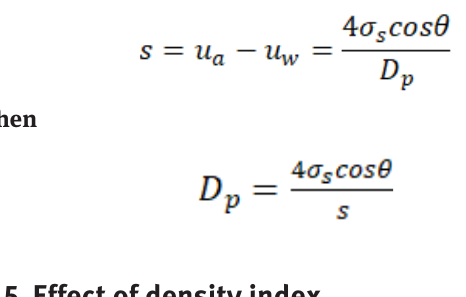
Figure 13: Water retention curves for all four types of sand.